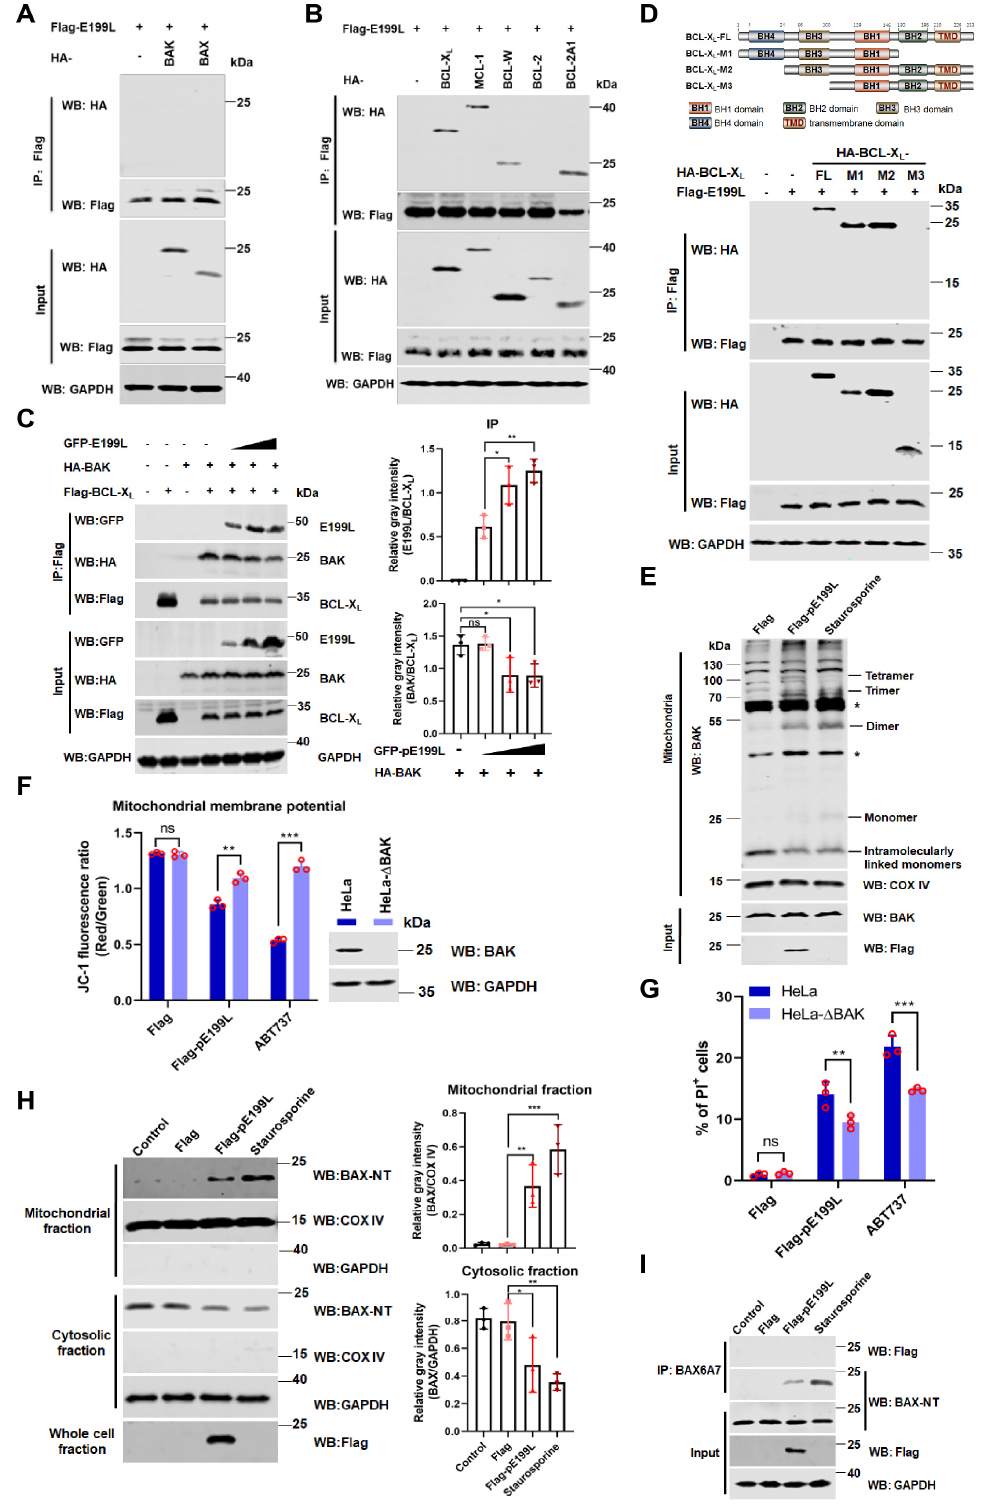
Figure 5. ASFV pE199L promotes BAK activation by competing with BAK for BCL-X L . ( A , B ) Detection of the interaction of pE199L and apoptotic effectors (BAK and BAX) or anti-apoptotic proteins (BCL-X L , MCL-1, BCL-W, BCL-2, and BCL-2A1). HEK293T cells were transfected with pFlag-E199L alone or together with HA-BAK, BAX, BCL-X L , MCL-1, BCL-W, BCL-2, or BCL-2A1. Co-IP and Western blotting were performed to test their interactions. ( C ) Disruption of BCL-X L -BAK complex by pE199L. HEK293T cells were transfected with Flag-BCL-X L , HA-BAK, and pGFP-E199L as indicated, and the competitive interaction between proteins was detected by Co-IP and Western blotting (left). Ratios of pE199L or BAK and